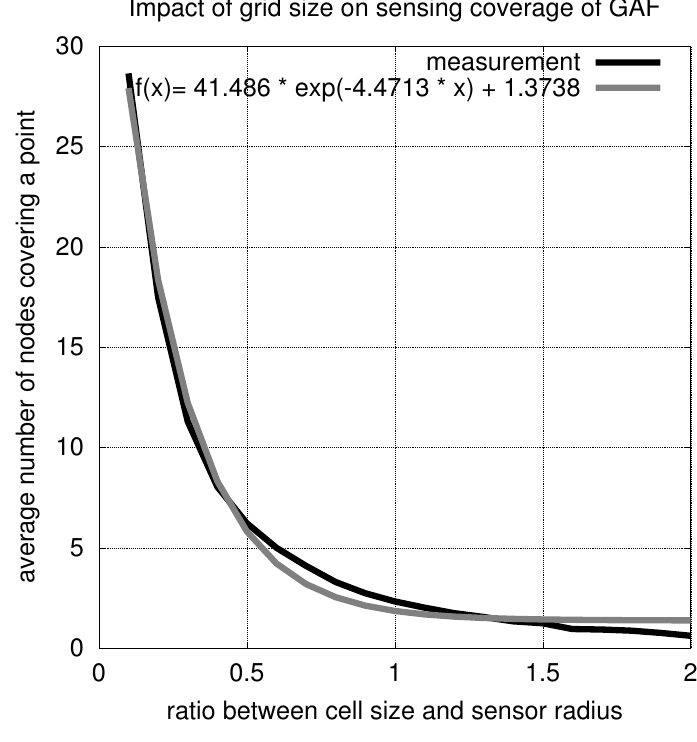
Figure 7. Determining GAF cell size with respect to k